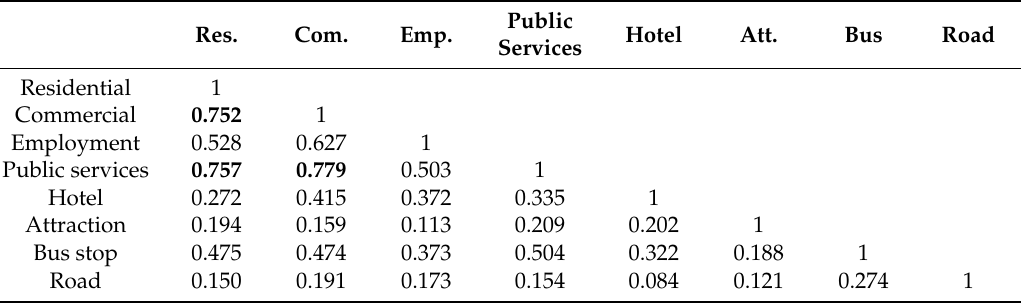
Table 2. Pearson correlation coefficient for explanatory variables.